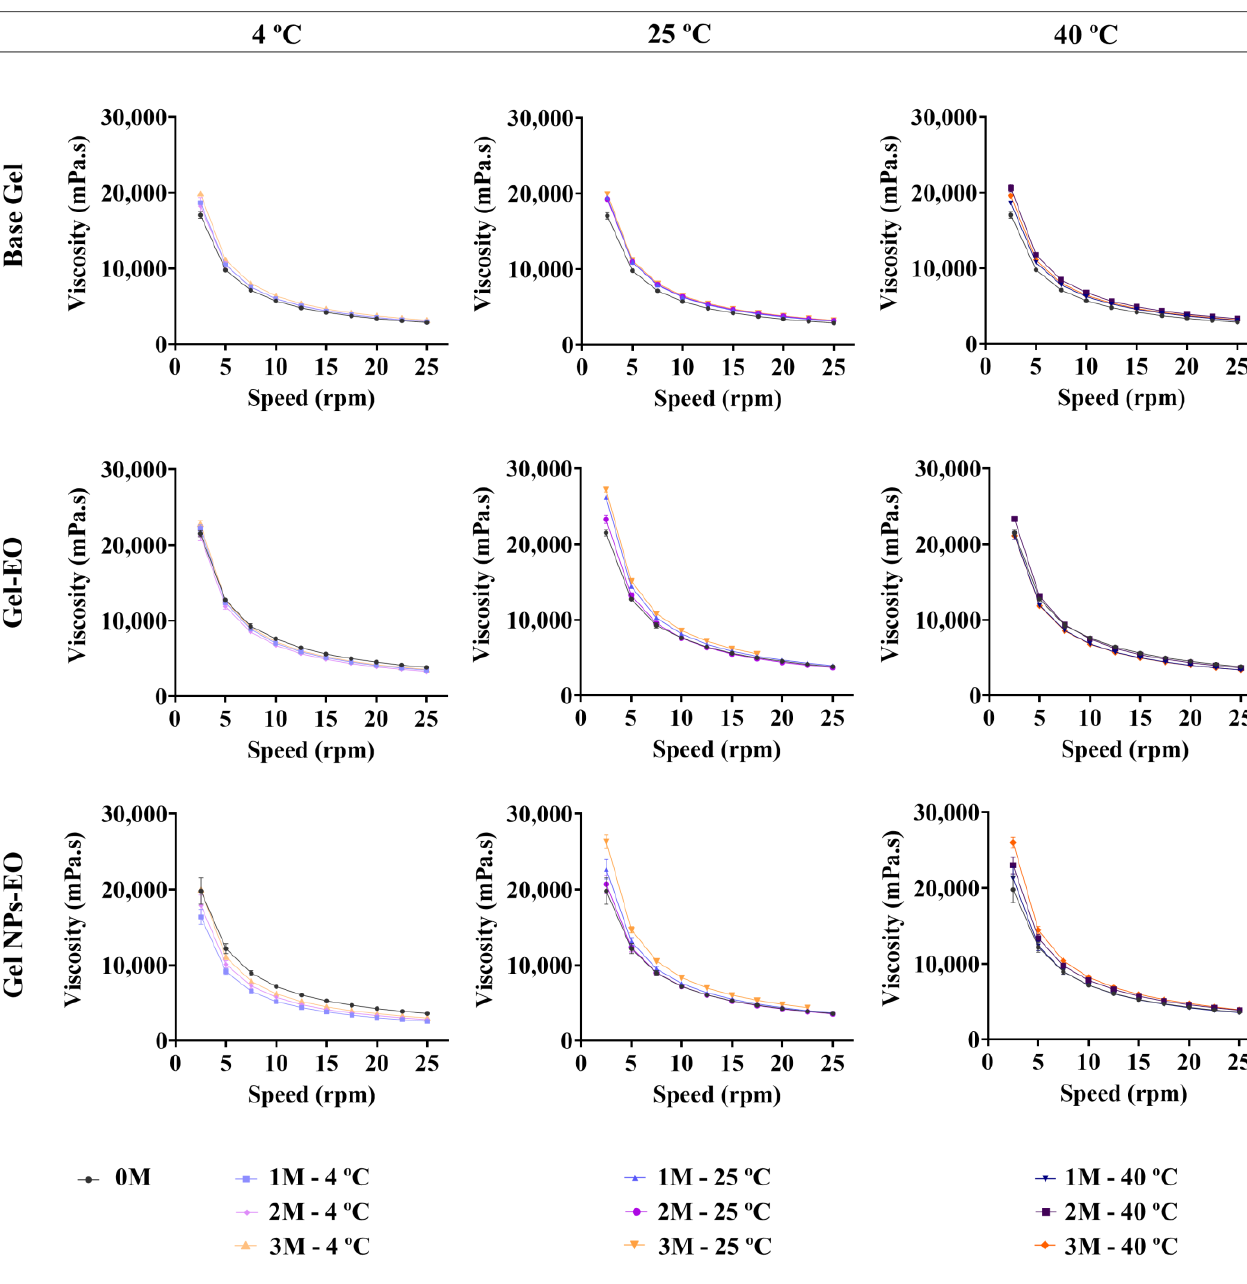
Figure 2. Evaluation of the viscosity (mPa · s) profiles of the prepared formulations: Base Gel, Gel-EO and Gel NPs-EO stored for 0, 1, 2 and 3 months (0 M, 1 M, 2 M and 3 M) at 4, 25 and 40 °C. Results are shown as the means ± SDs of 3 replicates.